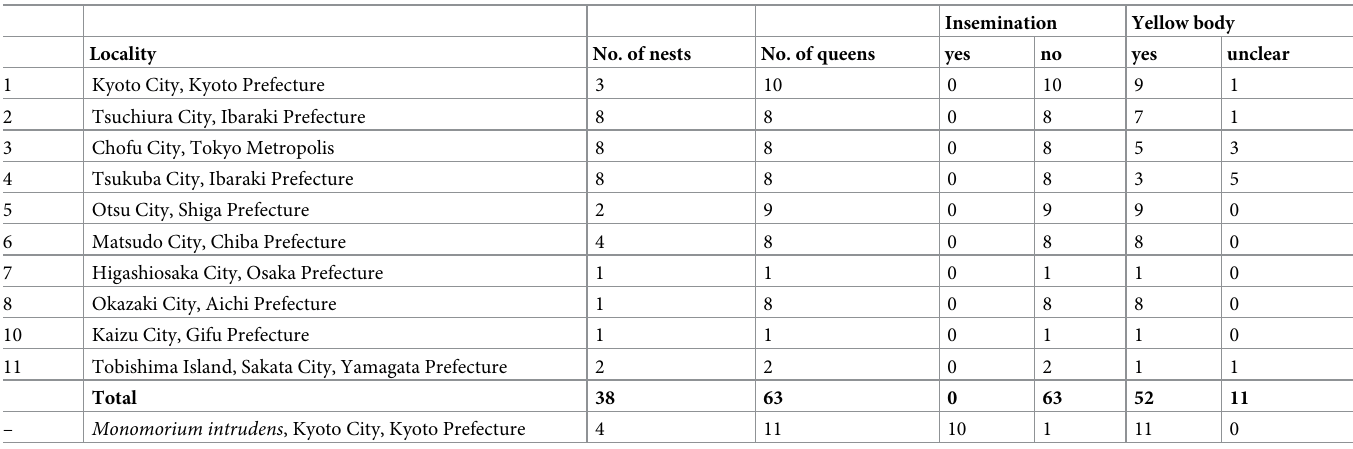
Table 2. Dissected queens from each sampling site.